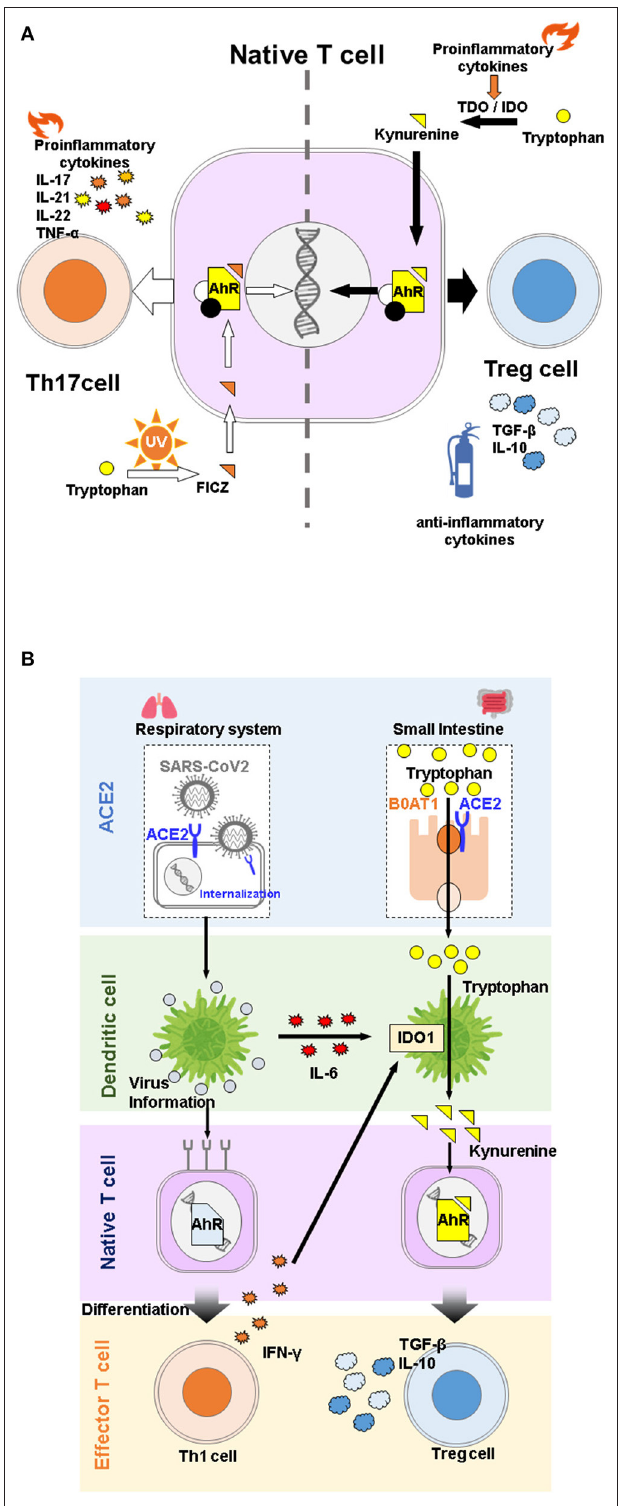
FIGURE 1 | (A) Effects of different tryptophan metabolites on differentiation of native T cells via . aryl hydrocarbon receptor (AhR) activation. Despite belonging to the same pathway, 6-Formylindolo[3,2-b]carbazole (FICZ) promotes differentiation of native T cells into Th17 cells, and induces